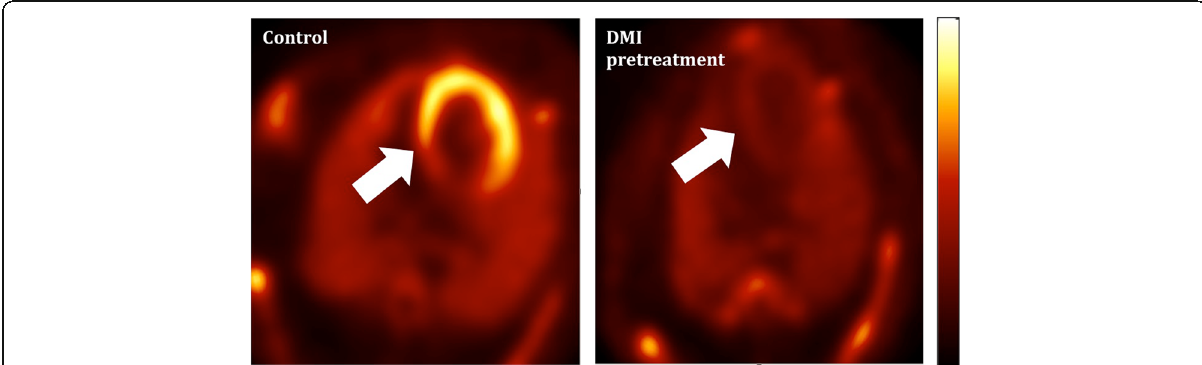
Fig. 5 Transverse image of 18 F-LMI1195 uptake in rabbit heart, showing control (left) and with DMI pretreatment (right). Averaged scan 10 – 30 min after tracer injection. With permission of